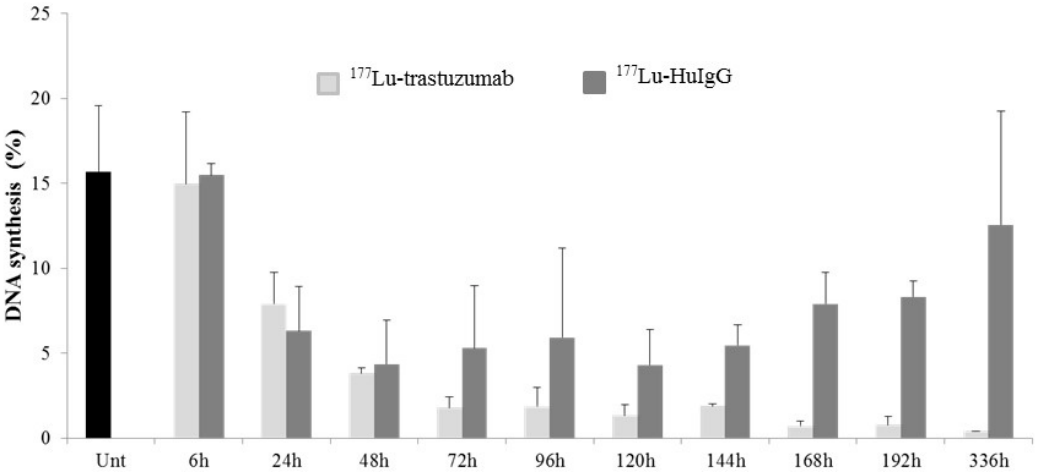
Figure 4. Analysis of DNA synthesis in LS-174T tumor xenografts following treatment with 177 Lu-trastuzumab. Values are the average and standard deviation of three analyses.